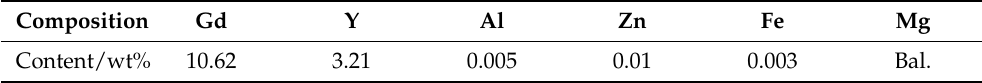
Table 1. Chemical composition of as-cast GW103